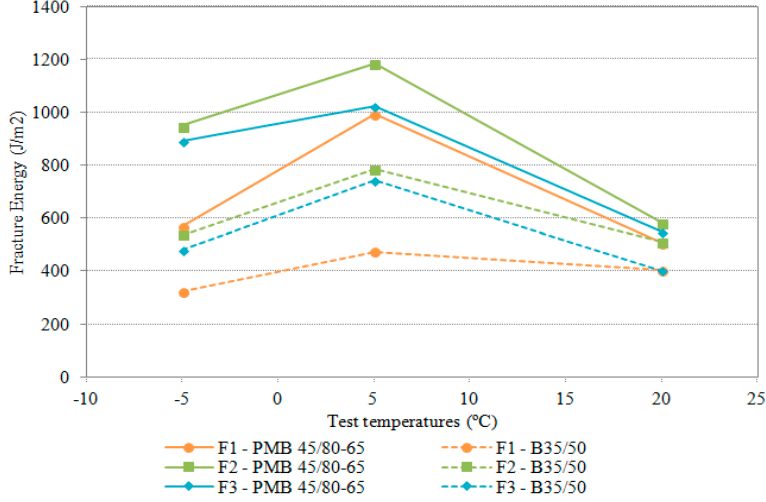
Figure 8. Fracture energy versus temperature.